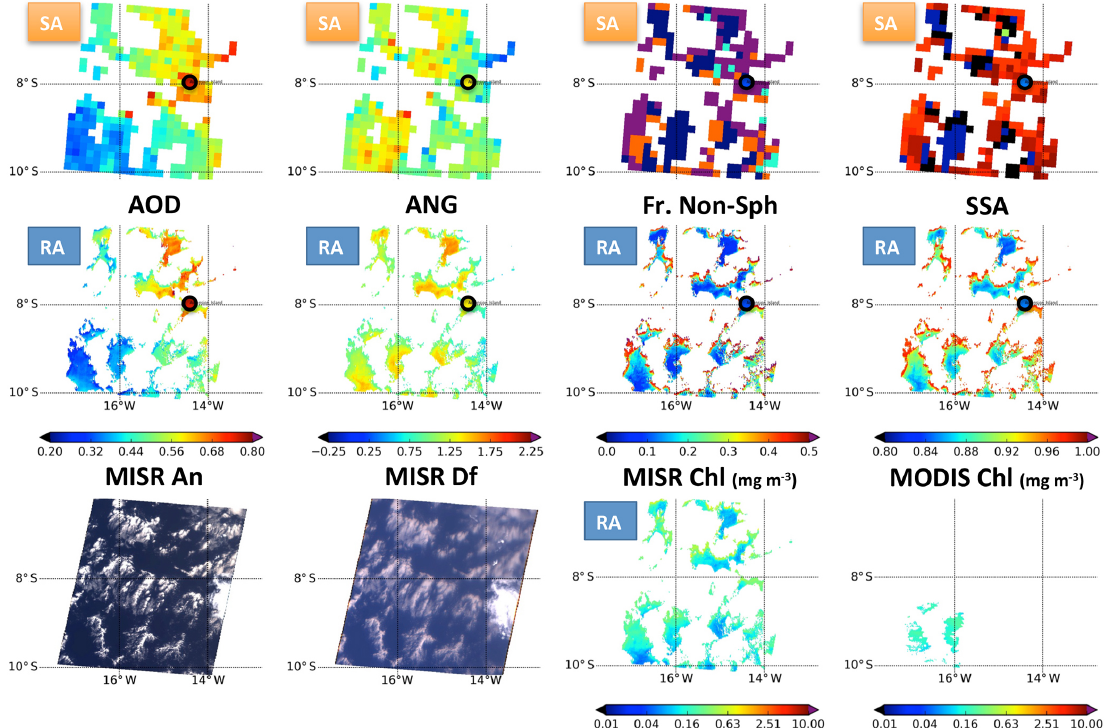
Figure 6. Same as Fig. 5, but for data acquired on 31 August 2003, 11:26Z: Terra orbit 19690, MISR blocks 96–98, in the mid-South Atlantic Ocean near Ascension